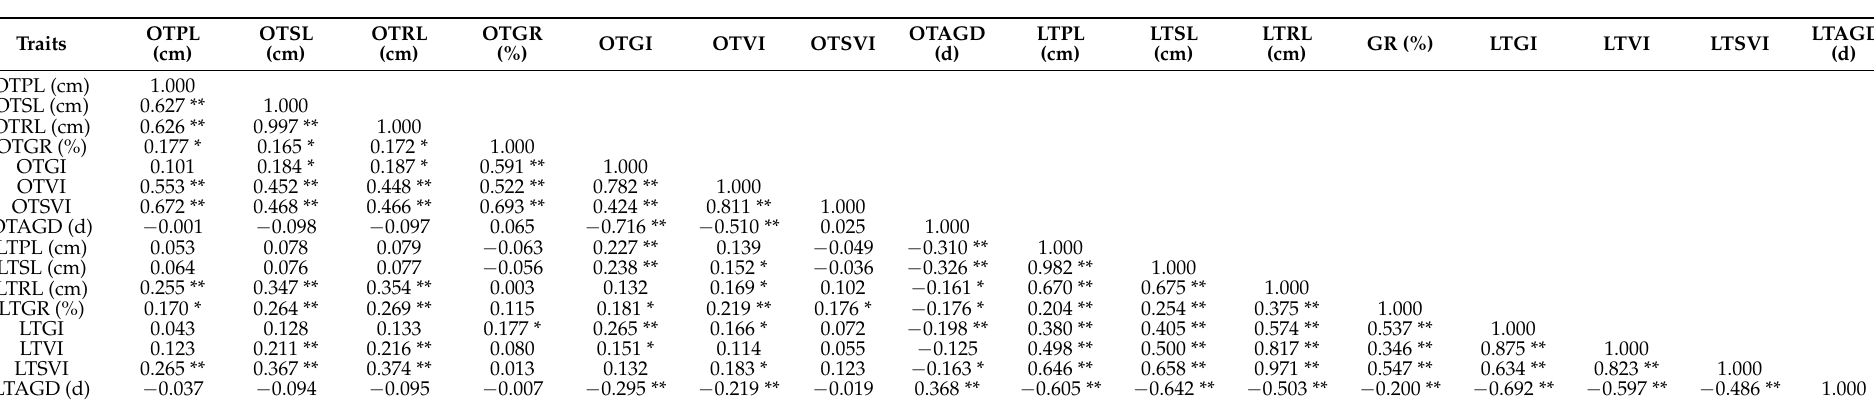
Table 2. Correlation coefficients (r) between plumule length, seedling length, root length, germination rate, germination index, vigor index, simple vigor index, and average germination days of IBM Syn10 population under optimum or low